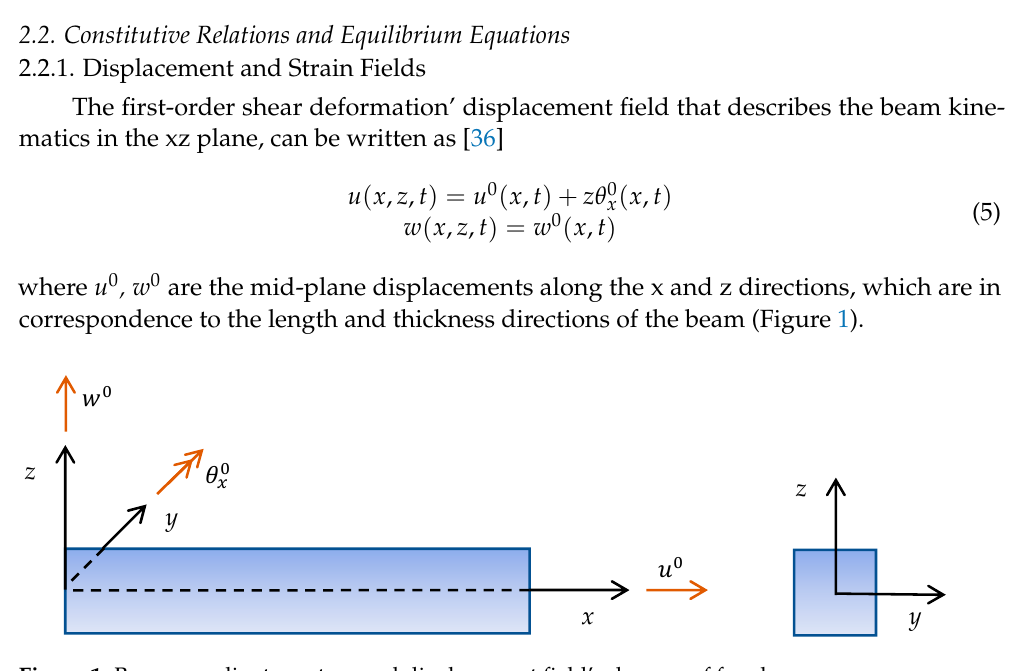
Figure 1. Beam coordinate system and displacement field’s degrees of freedom. θ 0 x is the rotation of the beam’ mid-plane around the y direction. The superscript 0 denotes the association of the degree of freedom to the mid-plane of the beam. The model based on this displacement field will be referred to as FSDT in short.